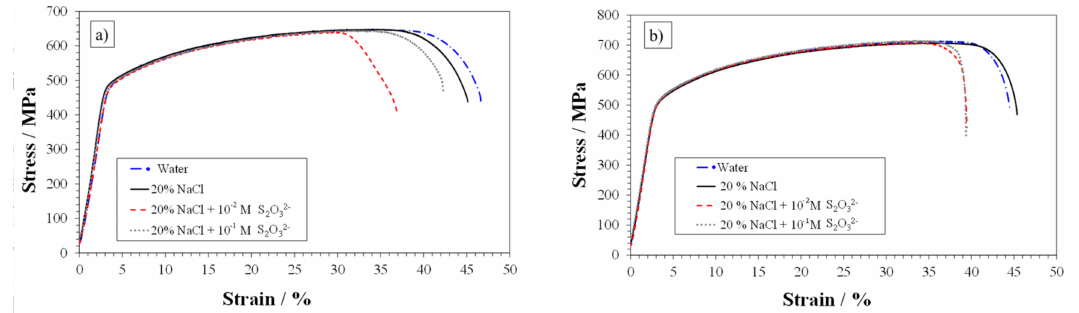
Figure 2. Stress–strain curves obtained during SSRT performed on DSS 2304 ( a ) and LDSS 2404 ( b ) at 80 ◦ C, in water and in 20% NaCl solution, in the absence and in the presence of 10 − 2 and 10 − 1 M S 2 O 32 − .